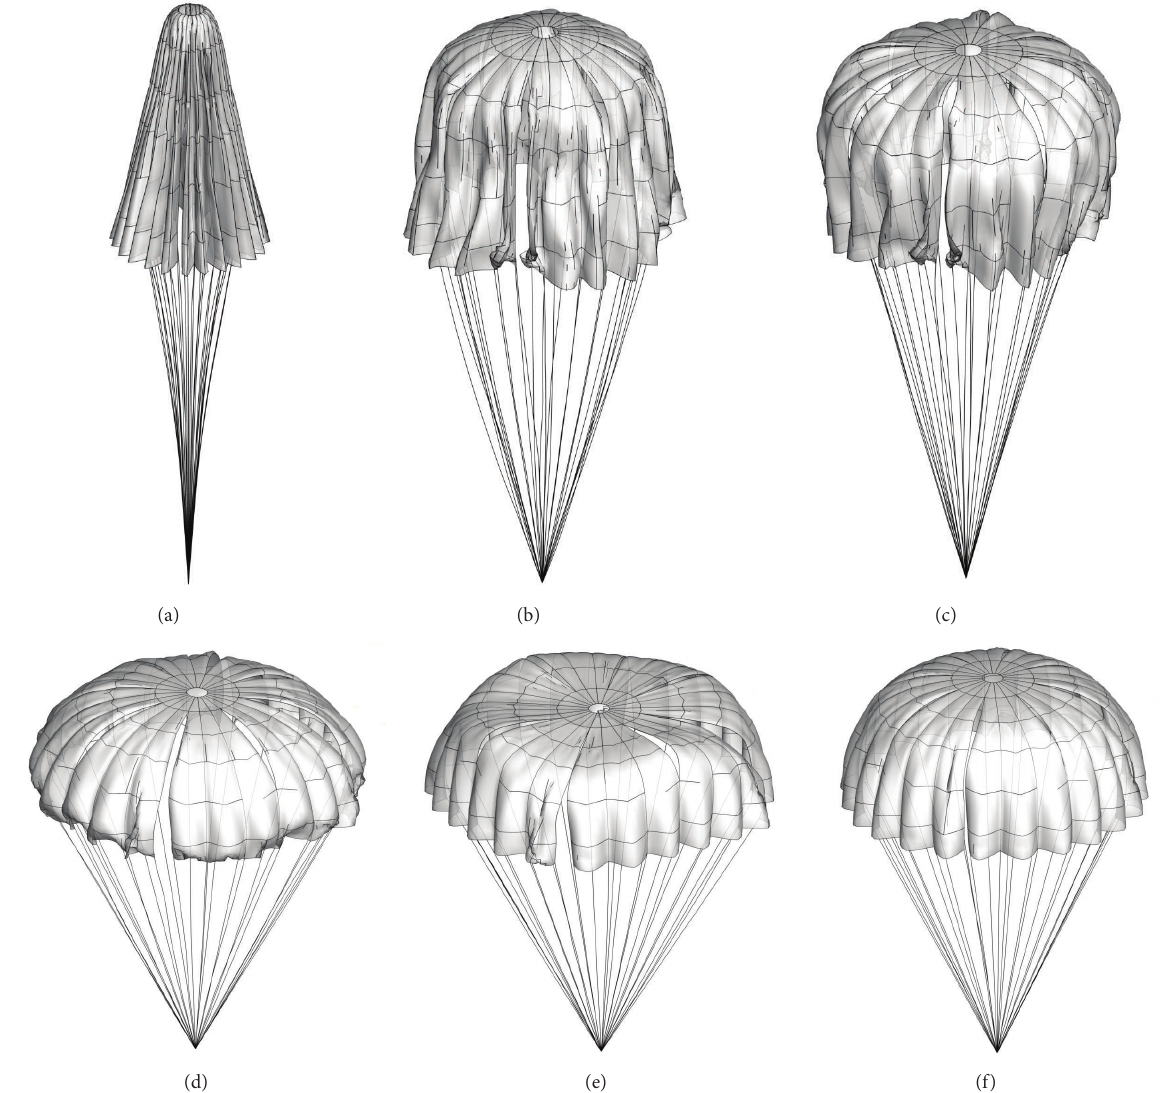
Figure 4: 3D canopy shape during inflation versus time: (a) 0.18, (b) 0.54, (c) 0.62, (d) 0.95, (e) 1.6, and (f) 2.0.